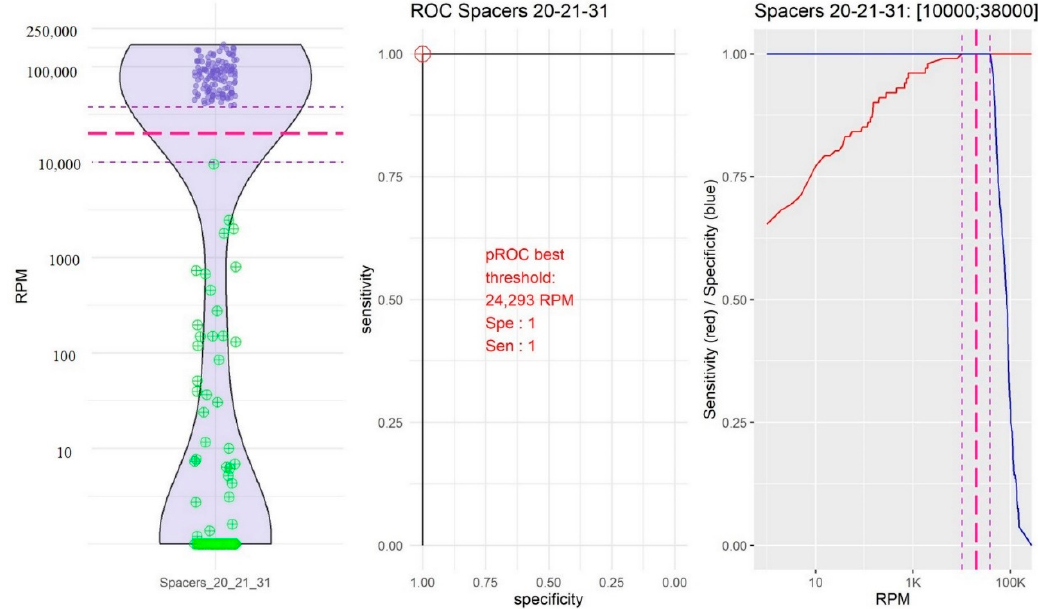
sent” spacers according to the membrane-based spoligotyping. Green circles represent the “absent” spacers according to the membrane-based spoligotyping. Dotted red line: RPM threshold choice (50 RPM). In the middle: Receiver operating characteristic (ROC) curve for spacers 10 and 14. Red circle represents the best RPM threshold. On the right: Sensibility (red line) and specificity (blue line) compared to the membrane-based spoligotyping according to the variable RPM threshold. Dotted purple line: RPM thresholds between which the sensitivity and the specificity are maximized. Dot- ted red line: RPM threshold choice (50 RPM).